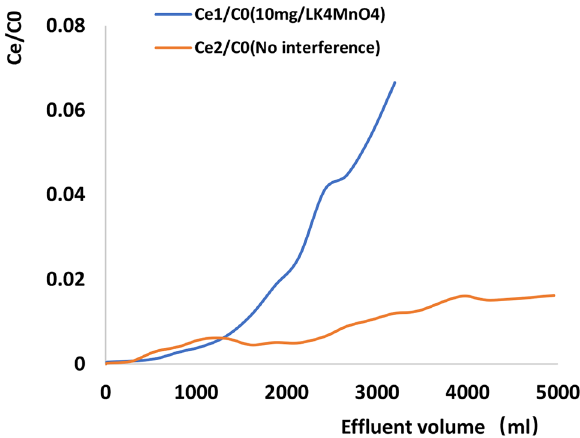
Figure 13. Removal efficiency of pentavalent antimony in water by the same 3.5-g rGO/NZV-FeZn column under the pentavalent antimony water containing 10 mg/LKMNO 4 .